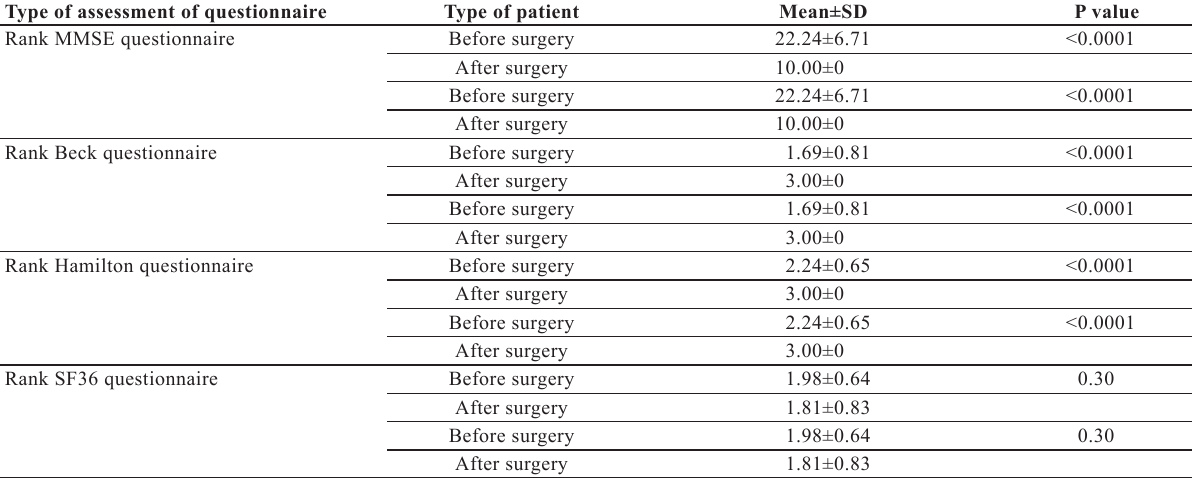
Table 2. Comparative assessment of cognitive impairment, depression, anxiety and quality of life in brain tumor patient before and 10 days after